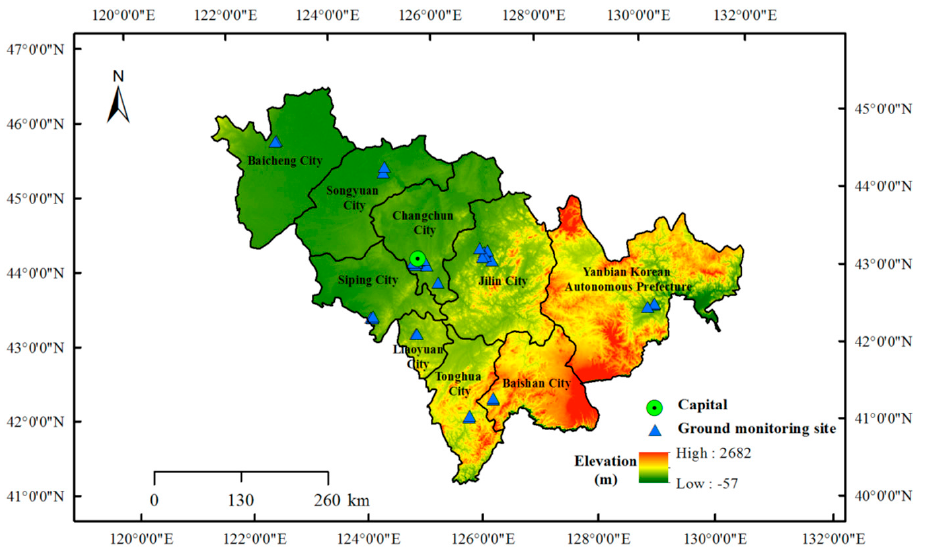
Figure 1. Provincial topography and atmospheric environmental monitoring sites in Jilin Province. The blue solid triangles represent the sampling locations in nine prefecture-level cities; the black solid lines are the boundary of each prefecture-level city; the green solid circle is the capital (i.e., Changchun City) of Jilin Province.